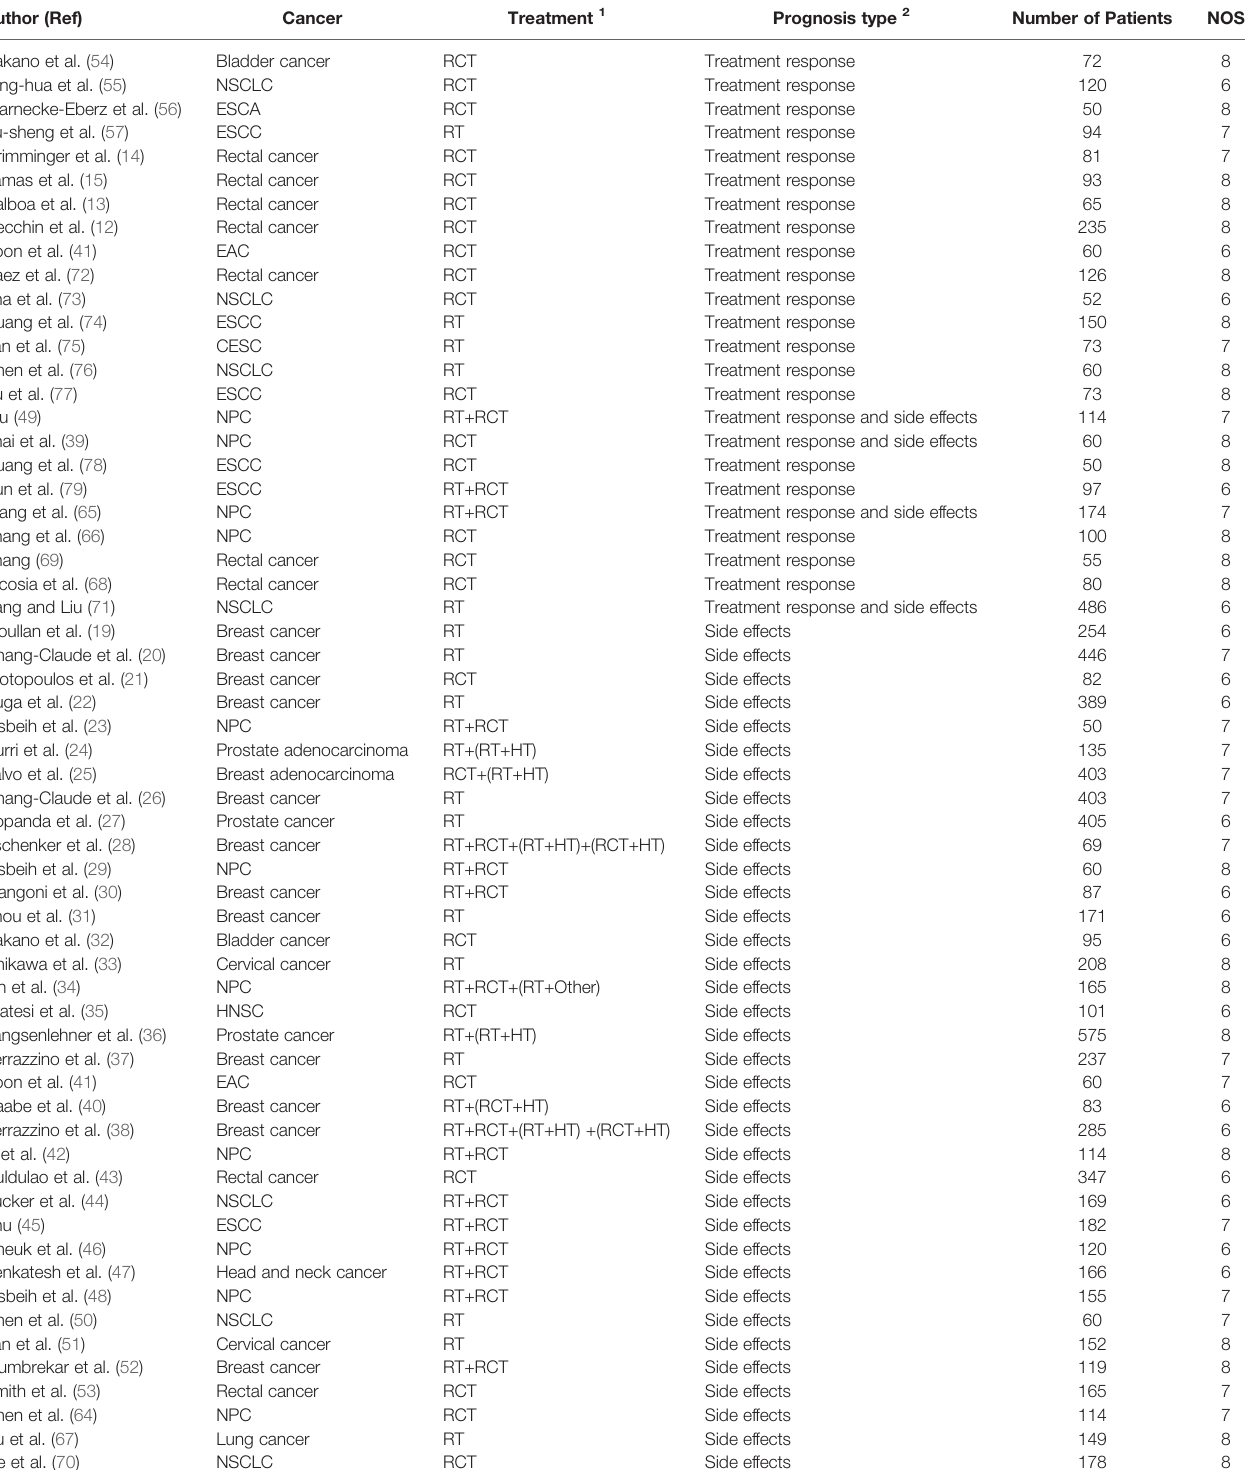
TABLE 2 | Characteristics of studies associated with XRCC1 rs25487 and